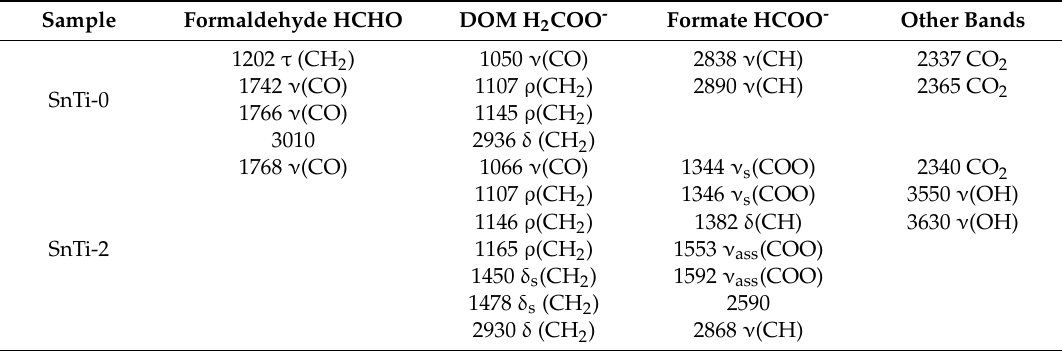
Figure 10. In situ DRIFT spectra of the SnTi-2 nanocomposite obtained during the heating in dry air at T = 300 °C after formaldehyde adsorption at room temperature. Table 3. Assignment of IR bands (cm − 1 ) for the intermediates of HCHO oxidation.